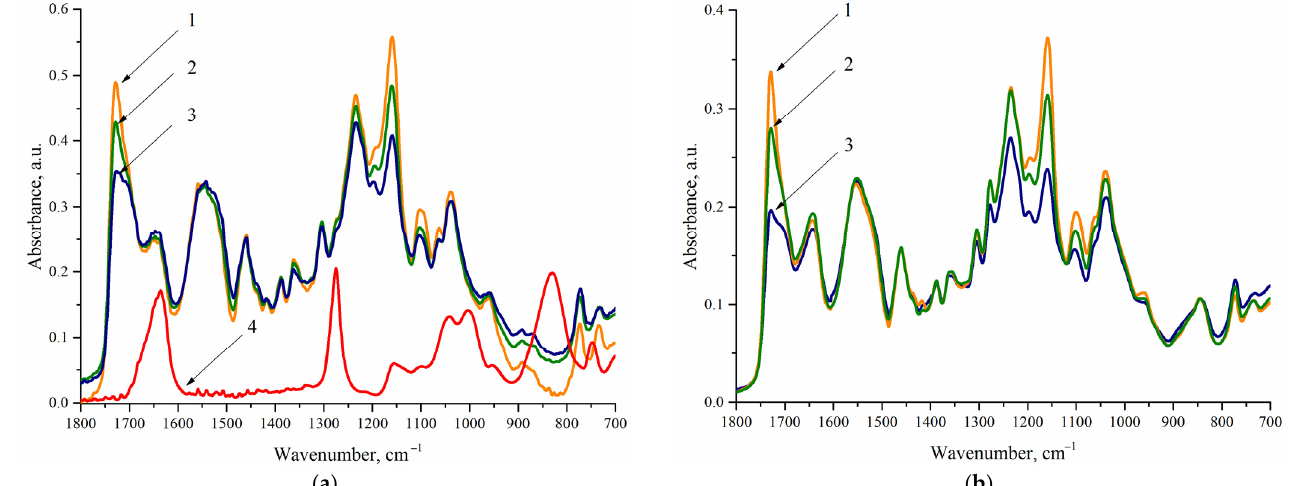
Figure 2. IR spectra for WPU films measured by ATR: ( a ) 1—sample 2.1; 2—sample 2.2; 3—sample 2.3; 4 –CDPN; ( b ) 1—sample 1.1; 2—sample 1.4; 3—sample 1.7.